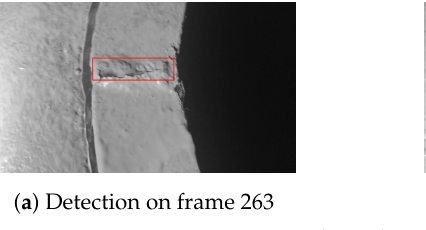
Figure 8. Object detection model is prone to detection bounding box jitters. Table 6. Object tracking test video A results (one confirmed crack existing in the